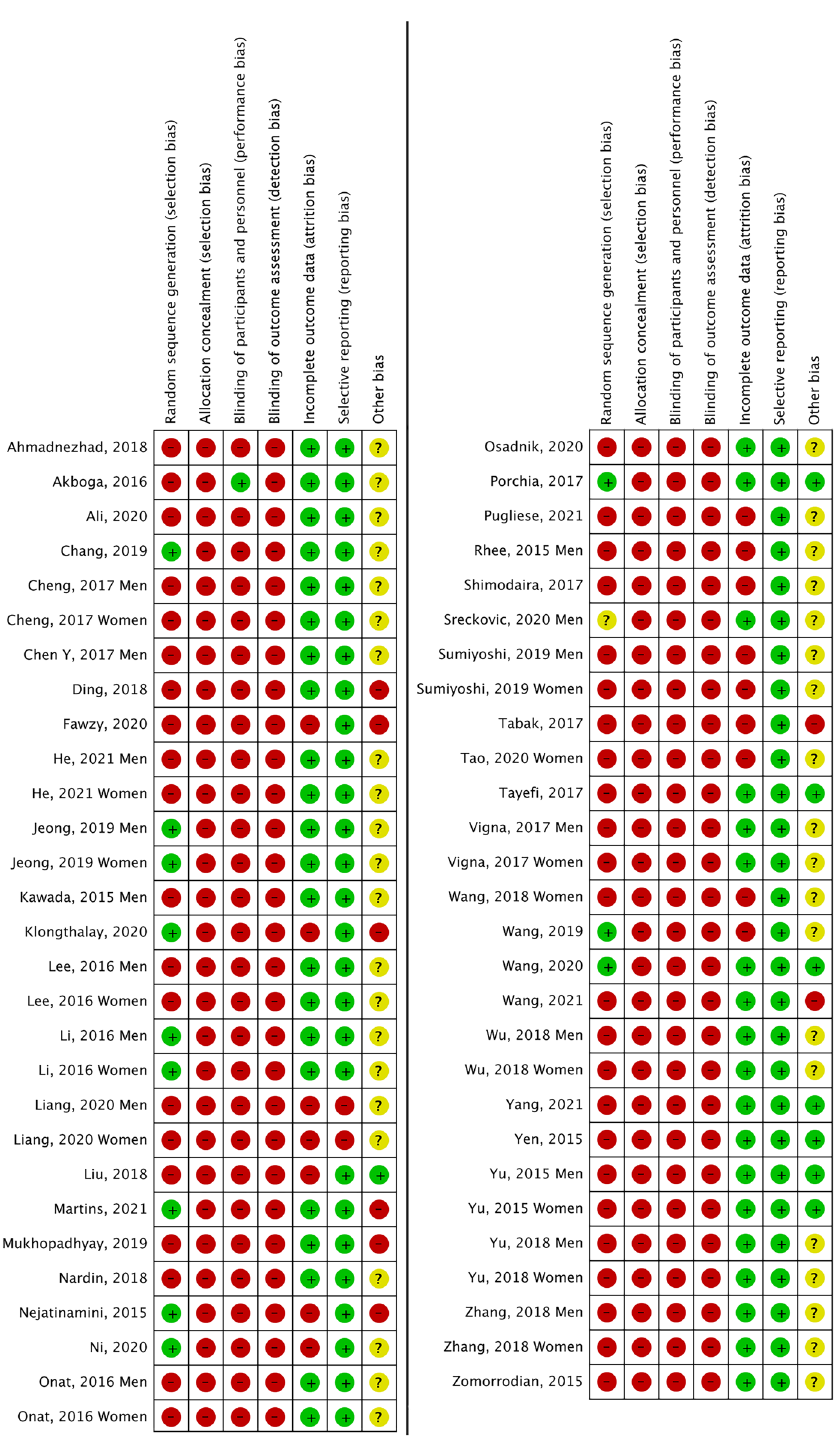
Figure 3. Summary of risk of bias by